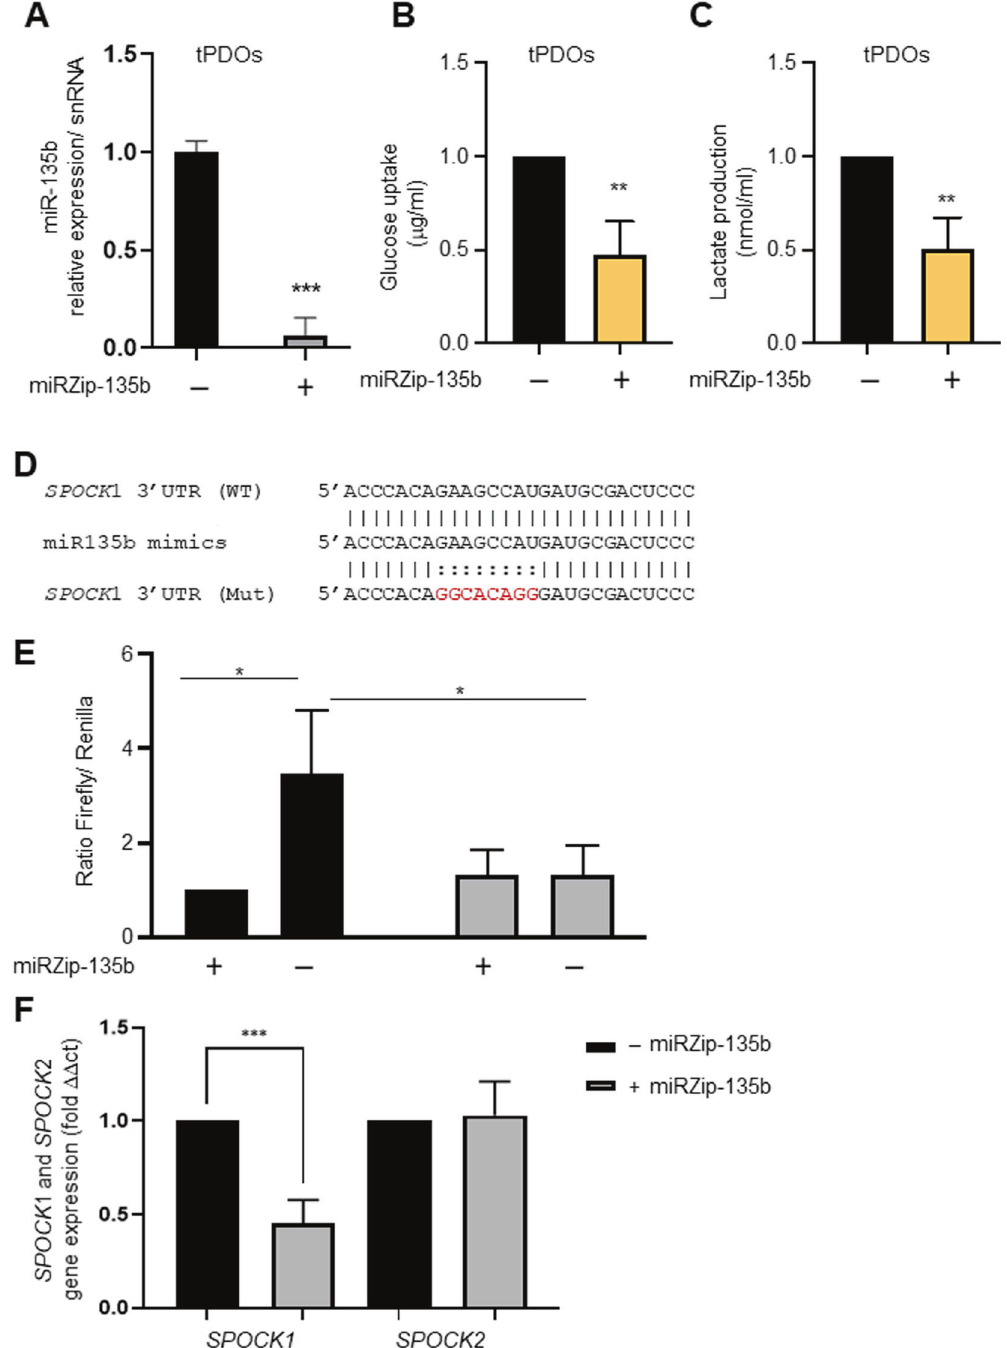
Fig. 5 The miR-135 targets SPOCK 1 gene impact glucose uptake and lactate production in CRC tPDOs. A Anti-miR-135 (miRZip-135b) signi fi cantly inhibits miR-135 expression in tPDO. B , C Anti-miR-135 (miRZip-135b) signi fi cantly inhibits glucose uptake and lactate production in tPDO. D The sequence of wild type (WT) and mutant (Mut) miR-135b target site in the SPOCK1 3 ′ -UTR shown in the frame. A point mutation (highlighted in red) was made in the seed region to block the binding between miR-135b. E According to dual-luciferase reporter assay, the relative luciferase activities of DLD-1 cells in SPOCK 1 ‐ WT + Anti-miR-135 (miRZip-135b) was signi fi cantly decreased, while in SPOCK 1 ‐ MUT + Anti-miR-135 (miRZip-135b) showed no signi fi cant variation (* P < 0.05). F Anti-miR-135 (miRZip-135b) signi fi cantly suppresses the expression SPOCK 1 but not SPOCK 2 in CRC mNPOs as models correspond to stimulating aerobic glycolysis in normal-appearing crypts in Apc Min/ + model of mice [88]. Such fi ndings suggest that LOH of the Apc gene is needed for tumours compared with normal adjacent tumour tissues and assessing the level of cellular metabolic changes. In support of tumorigenesis in mPOs versus mNPOs. Modelling the duodenal this, genes that mediate aerobic glycolysis, including Aldob , Cyba , polyp-derived organoids is a close fi t observed in the intestine as a Fabp 6, Hk 2, Spock 1 and Spock 2, are signi fi cantly induced in mPOs whole, including the large bowel [89]. Therefore, mPOs and